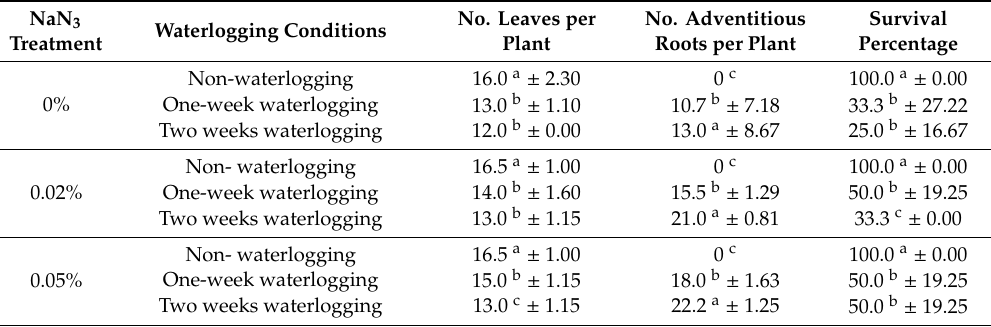
Table 3. Number of leaves, average number of adventitious roots produced, and survival percentage of okra plants grown from NaN 3 -treated seeds under waterlogging conditions 10